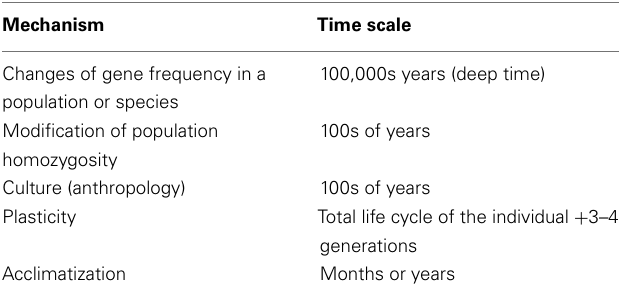
Table 1 |The five levels of stable evolutionary adaptation, their mechanism and time